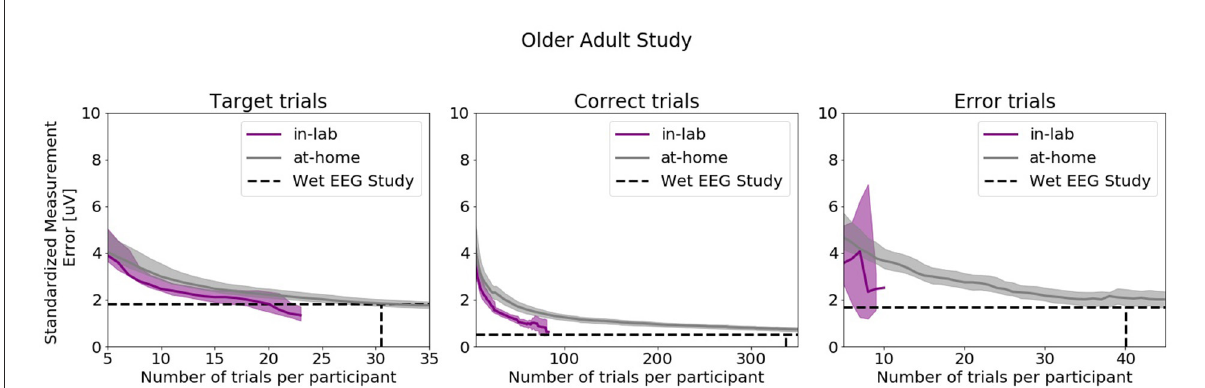
FIGURE10 Standardized Measurement Errors per number of trials of data collected in the laboratory under researcher supervision extracted from the Older Adult Study ( N 50). The purple line corresponds to data collected in the laboratory. The gray line corresponds to data collected in the home. = The black dotted lines correspond to the mean numbers of trials extracted from the wet EEG study. From left to right: Target Trials extracted from the Oddball task at electrode Pz, Correct Trials extracted from the Flanker task at electrode FCz, Error Trials extracted from the Flanker task at electrode FCz. The shaded areas correspond to the 95% confidence